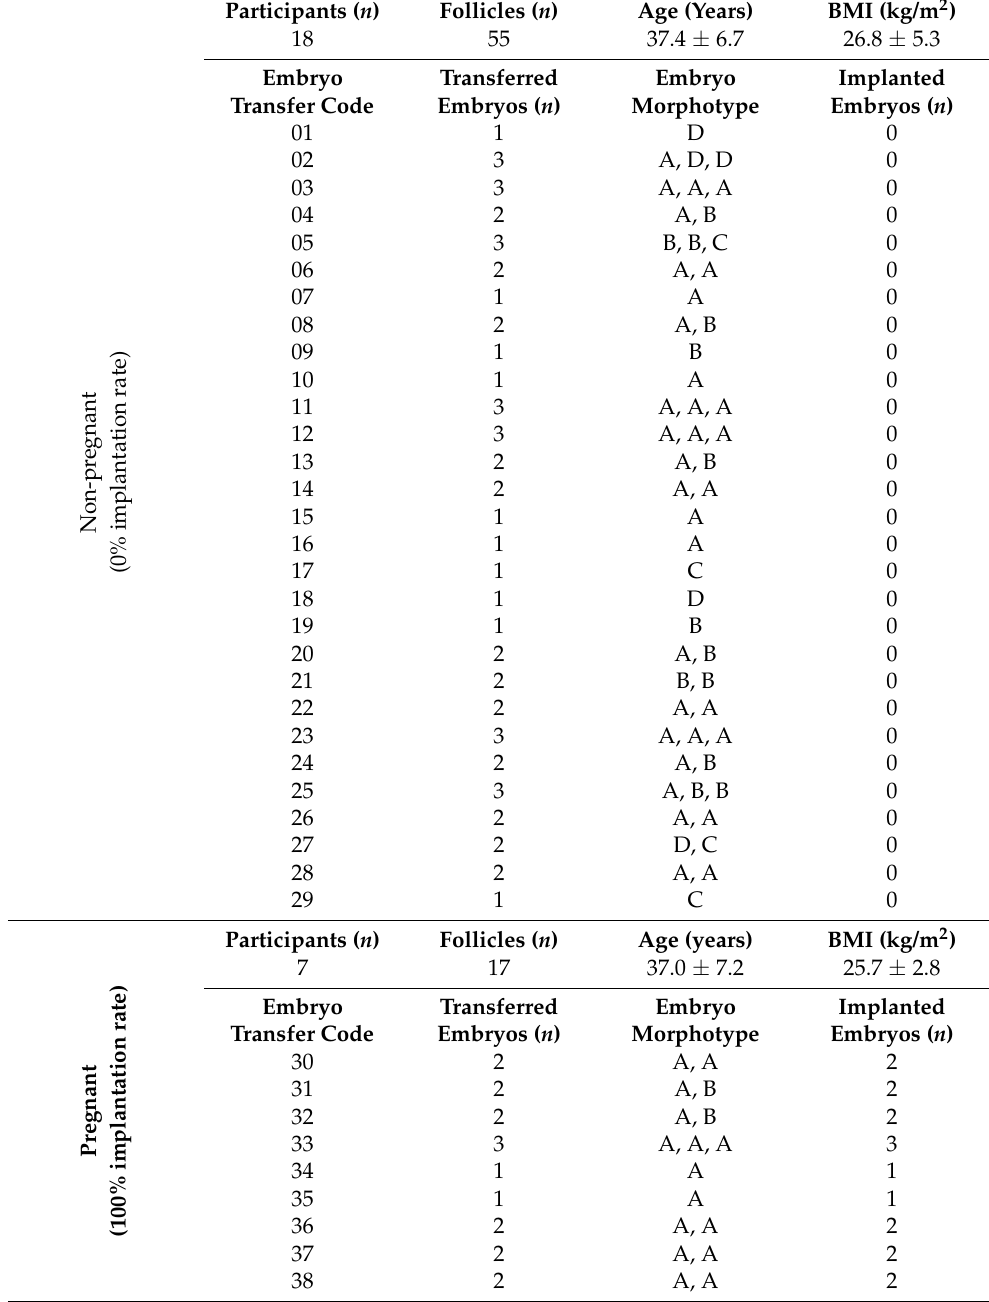
Table 1. Participants baseline